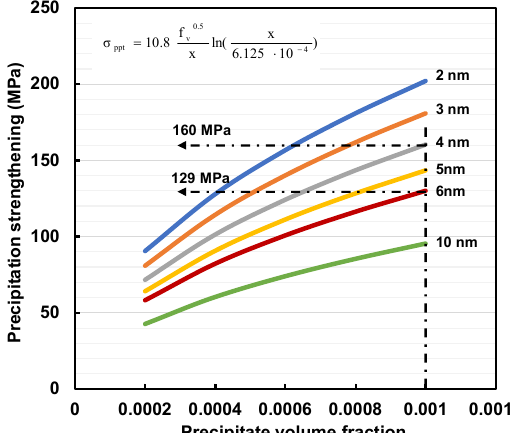
Figure 14. Contribution of precipitate size to precipitation strengthening according to the Ashby– Orowan model.